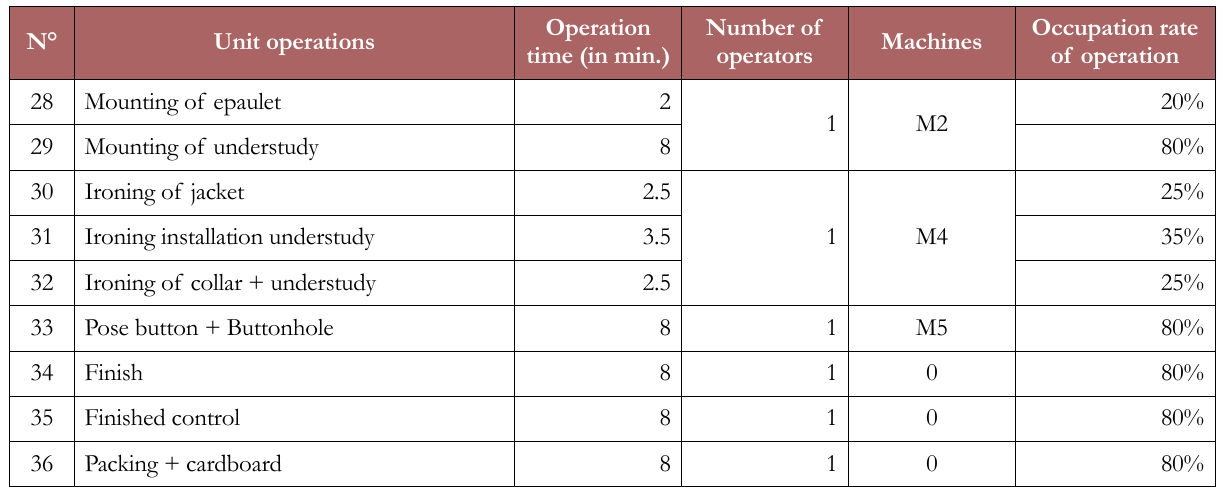
Table 2. The transformation operations and the occupation rates